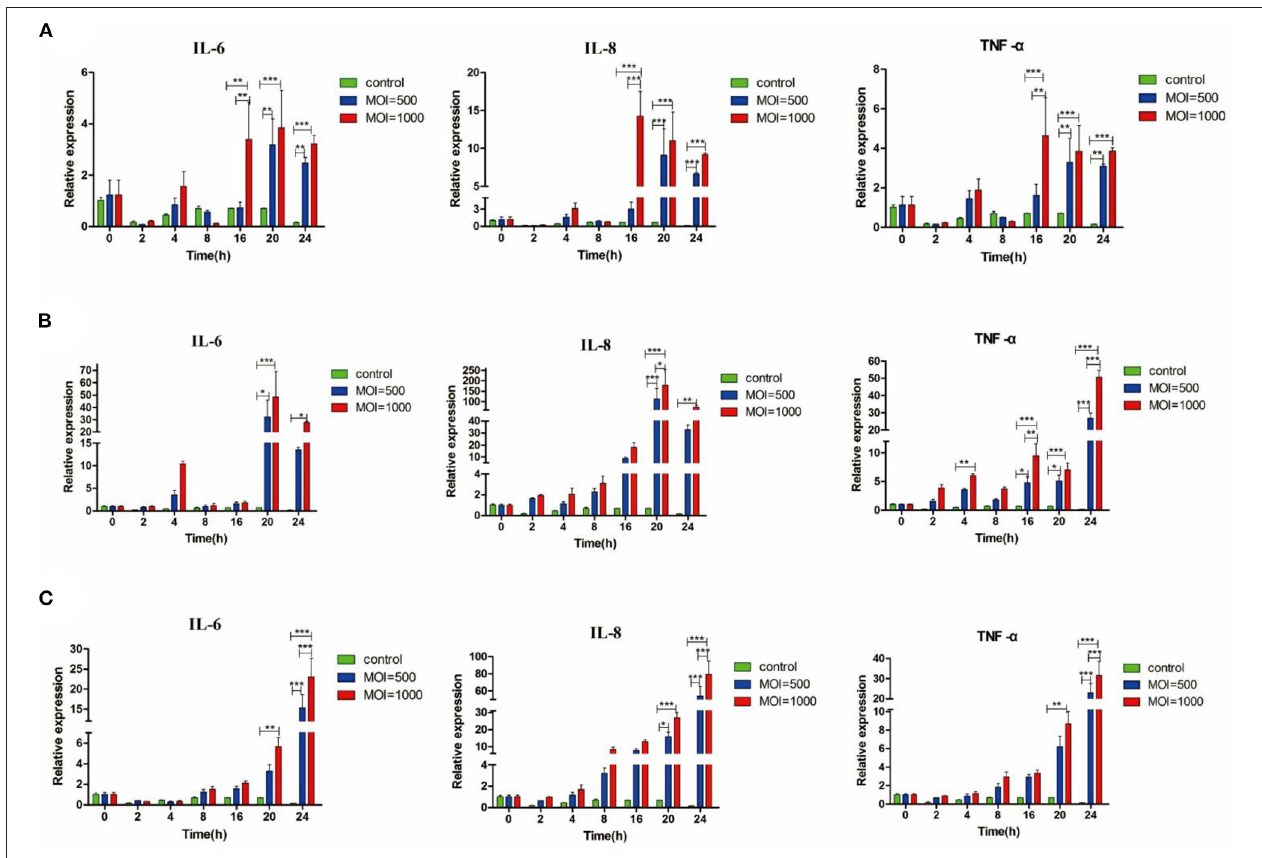
FIGURE 1 | M. bovis induced IL-6, IL-8, and TNF- α mRNA expression in BMECs. Relative expression of different cytokines from BMECs infected by three M. bovis, respectively, (A) BMECs infected by 39YC within 24h, (B) BMECs infected by PG45 within 24h, (C) BMECs infected by HB0801 within 24h. * p < 0.05, ** p < 0.01, and *** p <